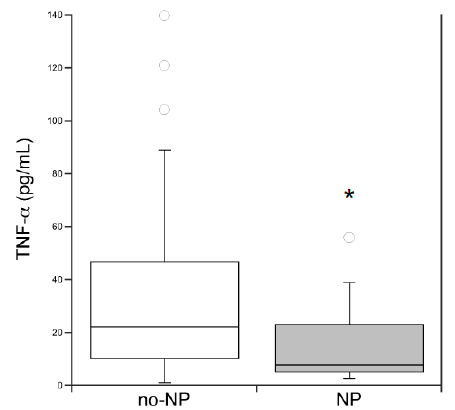
Figure 1. Comparison of salivary TNF- α levels between CF patients without nasal polyposis (no-NP: no-NTH / no-NP + NTH; n = 108) and with nasal polyposis (NP, n = 21); * p < 0.05, Mann–Whitney U